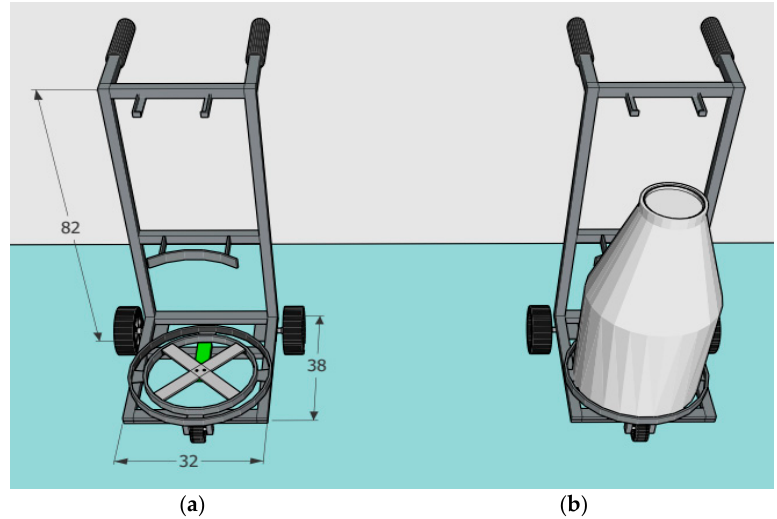
Figure 4. Milk wheelbarrow: ( a ) weight scale mechanism and ( b ) milk bucket positioning.